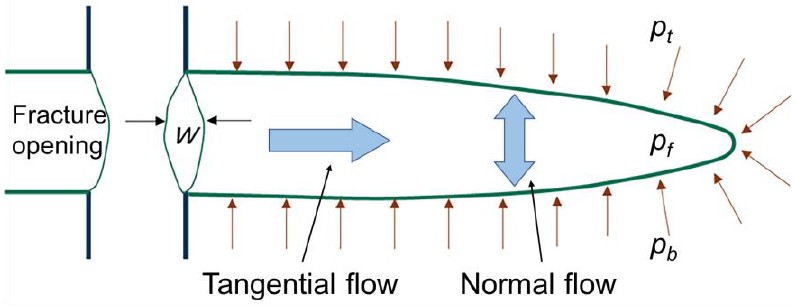
Figure 5. Fracturing fluid flow in hydraulic